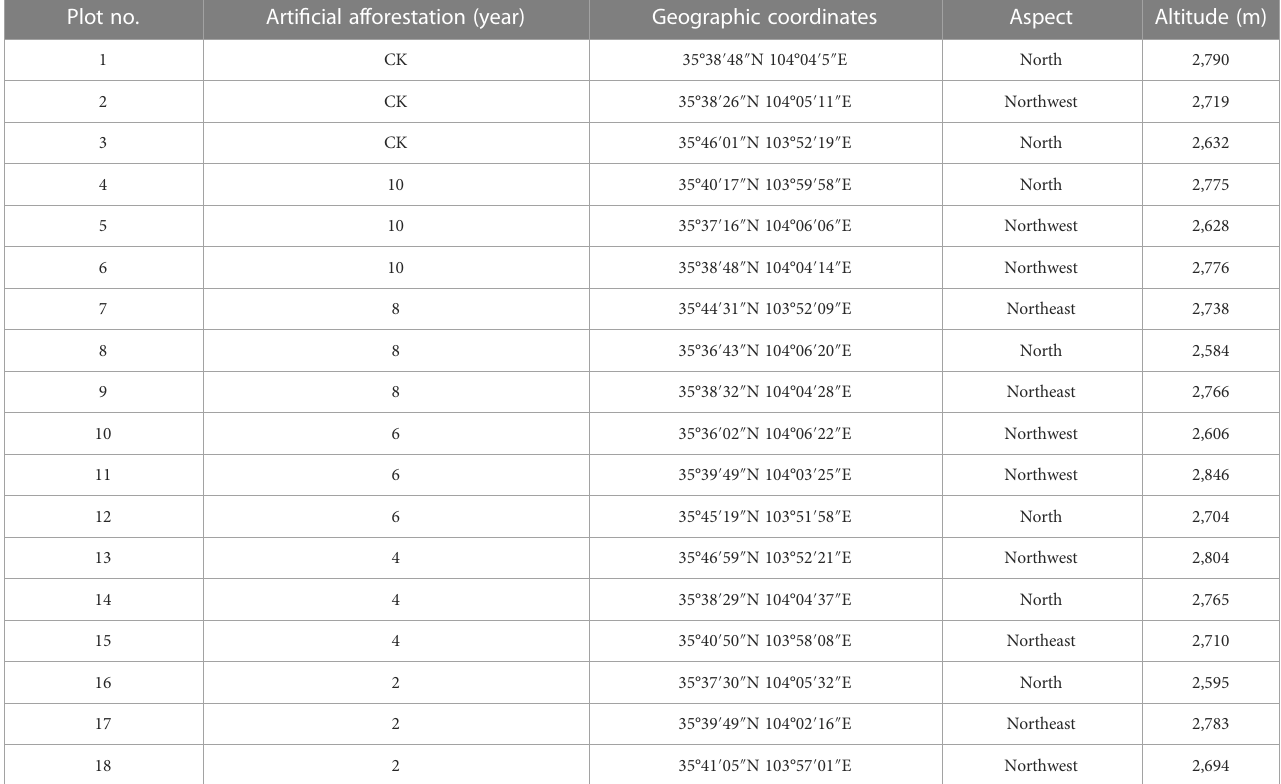
TABLE 1 Basic information of sample plots with different years of arti fi cial afforestation in the Maxian Mountains of the Loess Plateau. Plot no.